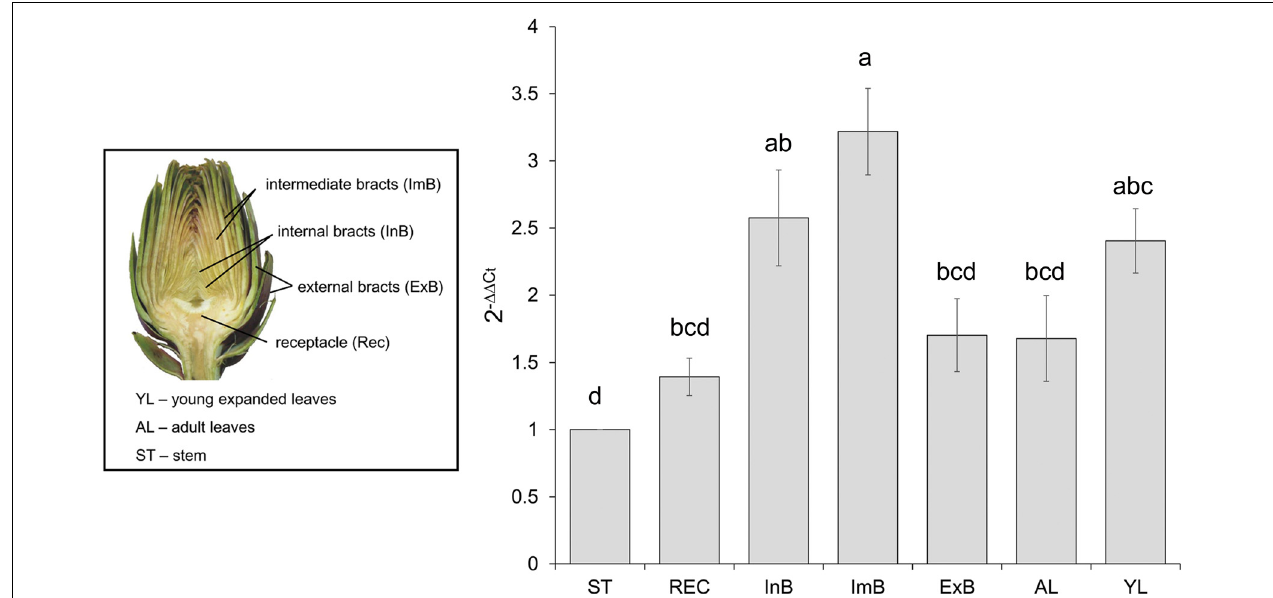
FIGURE 2 | CcMYB12 gene expression in different organs of artichoke. Quantitative Real Time PCR analysis was performed in the organs depicted in the photograph: stem (St), receptacle (Rec), internal bracts (InB), intermediate bracts (ImB), external bracts (ExB), adult leaves (AL), young leaves (YL), St is the calibrator. Elongation Factor EF1 α was employed as reference gene. Values are means ± SD of three biological replicates. Bars with different letters are statistically different to each other according to one-way ANOVA Tukey test ( p < 0.05).